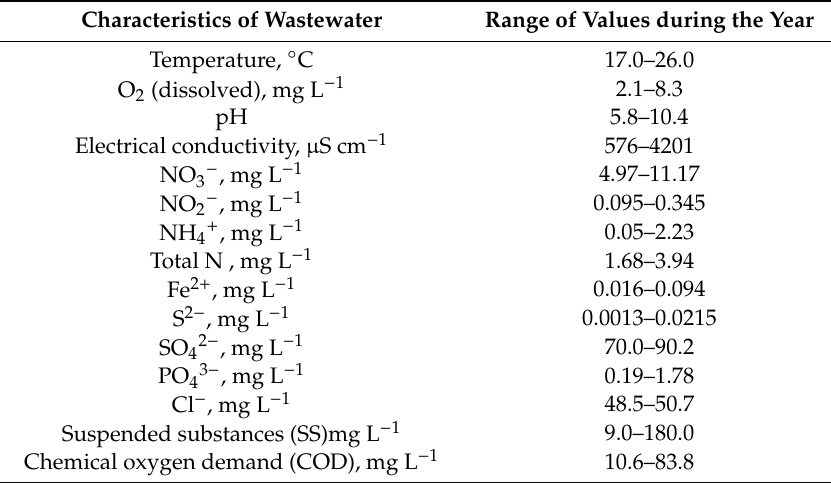
Table 1. Characteristics of wastewaters entering the constructed